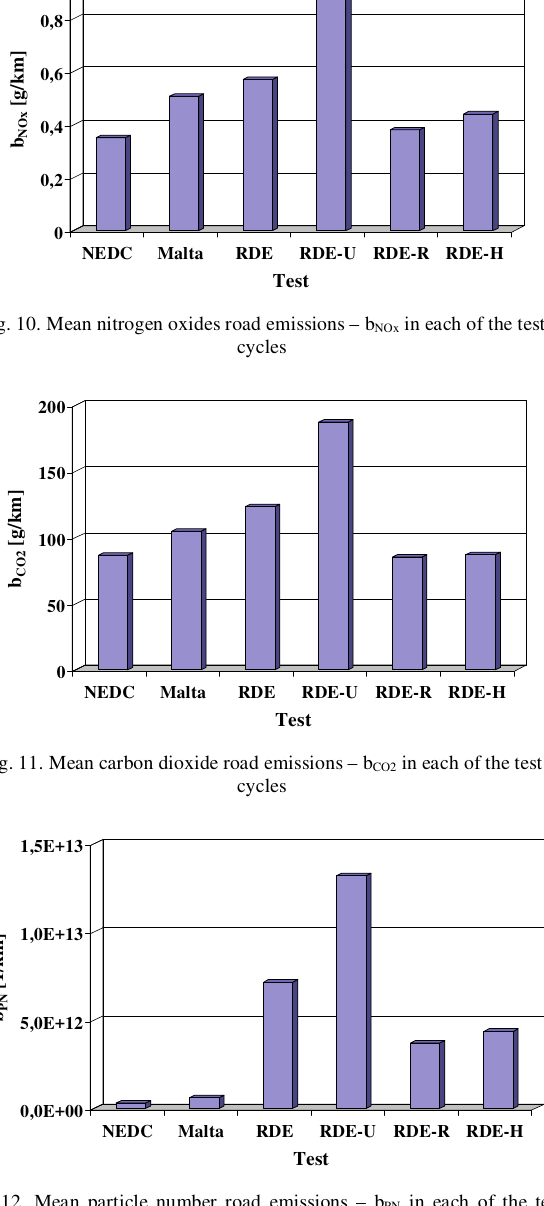
Fig. 13. Mean speed – v AV in each of the test cycles